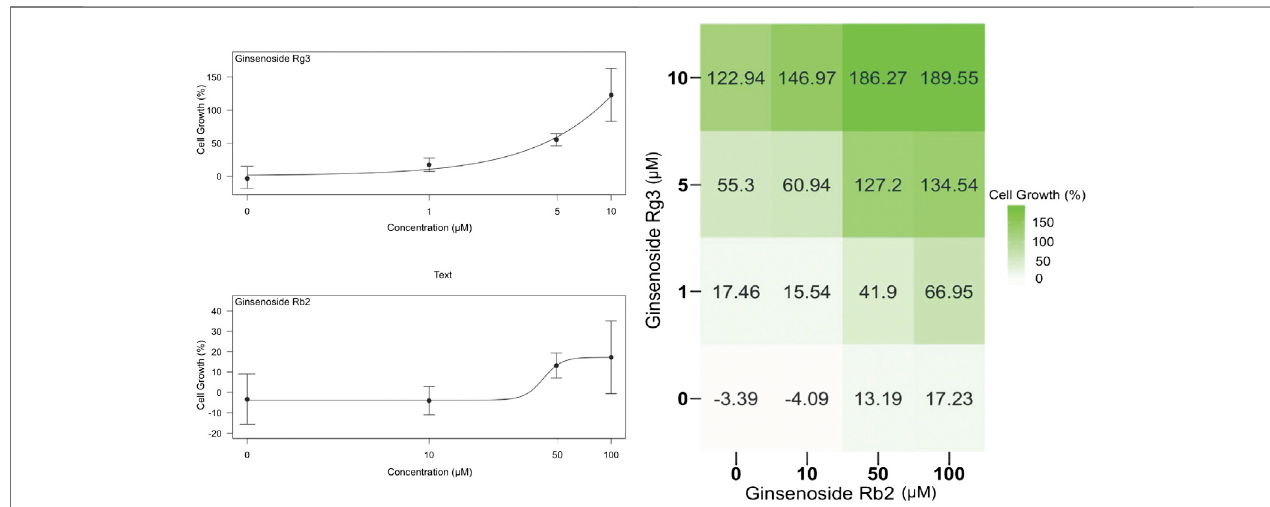
FIGURE 1 | Effect of individual ginsenosides Rg3 and Rb2 on cell growth on a semi-logarithmic plot (left) and the 4 × 4 combination response matrix (right) . By calculatingthesynergyscorewiththeBlissmethod,ginsenosideRb2andginsenosideRg3synergistically promotedendothelialcellgrowthwithaBlisssynergyscoreof 39.48. Data are represented as mean ± SD, n (cid:2)